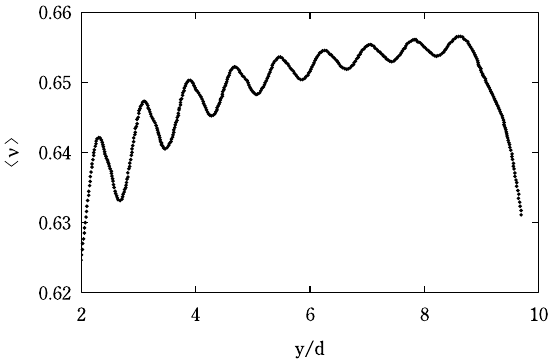
Fig 13 Solids fraction 〈ν〉 as a function of normalized height y / d from the floor for the case ν ∞ ＝